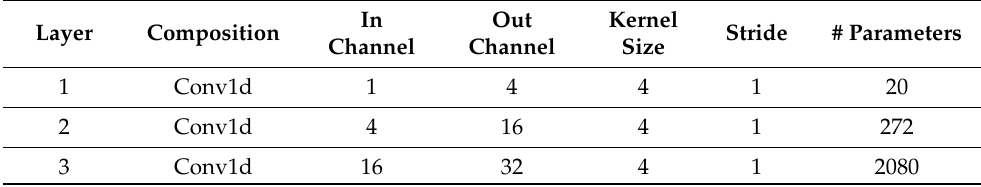
Table 4. Network layer structure of the encoder in DAE used for the proposed system. Layer